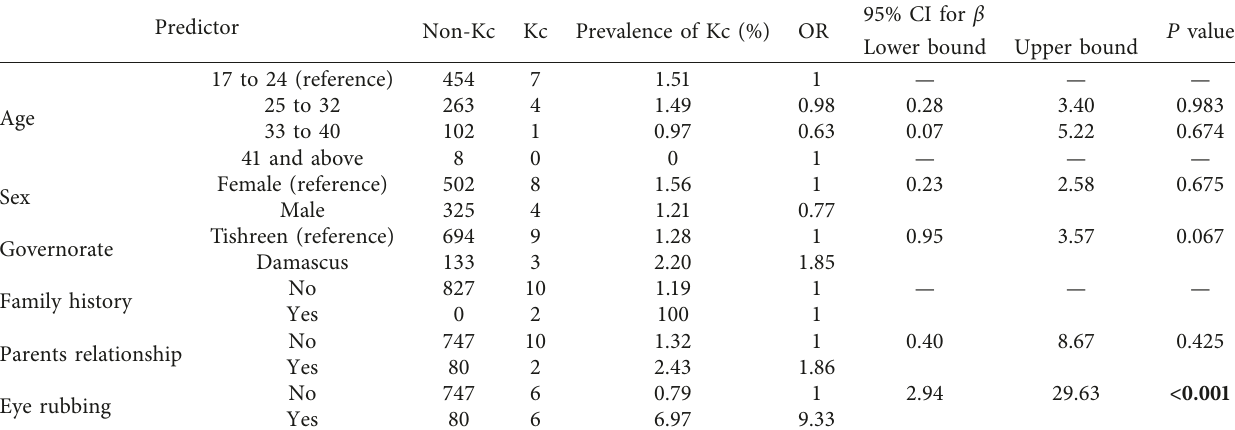
Table 4: Results of the univariate analysis ( n �